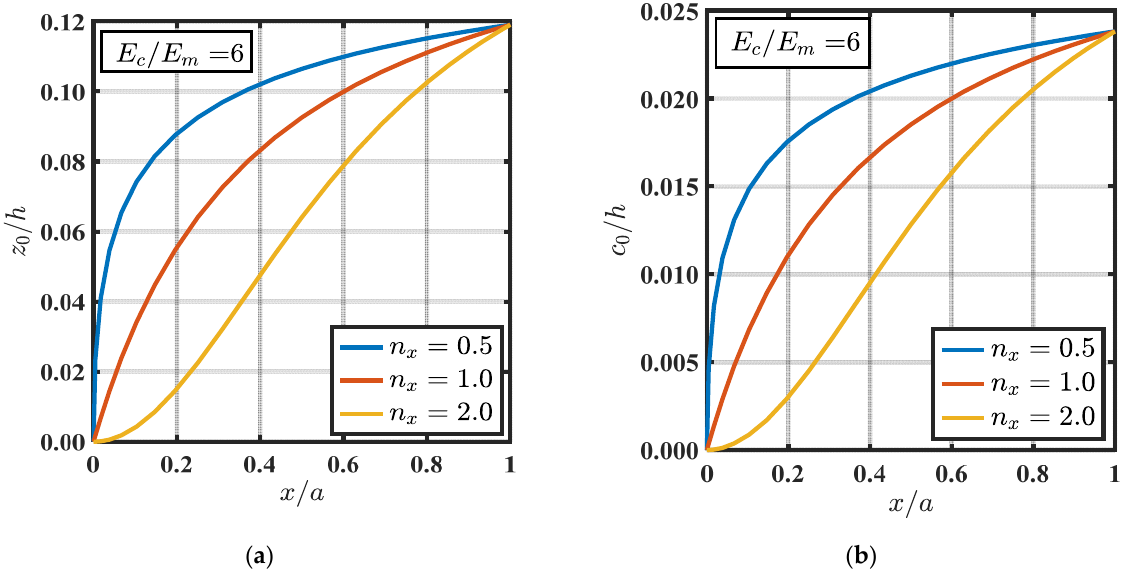
Figure 5. Neutral axis paramaters z 0 / h and c 0 / h at different n x and young’s modulus of ceramic and metal, E c / E m = 6 at ( a / h = 10, n z = 1 ) ( a ) for z 0 / h and ( b ) for c 0 / h